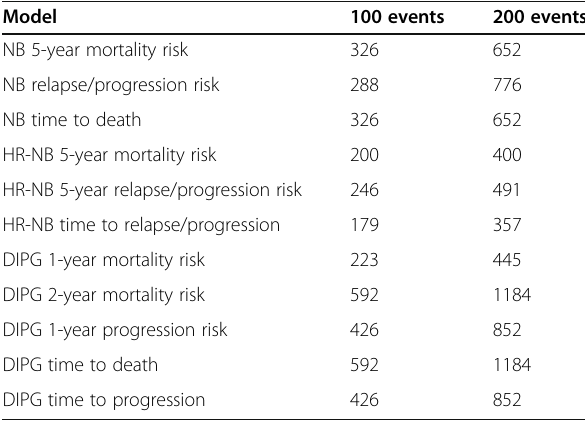
Table 5 Sample sizes for external validation